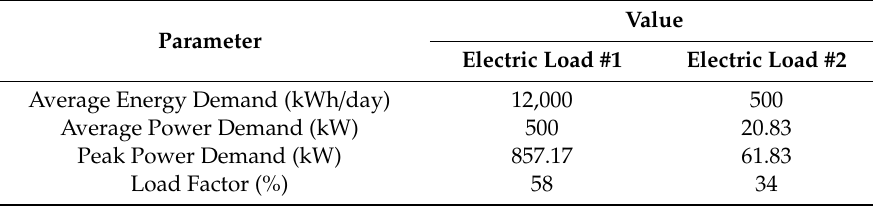
Figure 1. Total electrical load profile (first year of project lifetime). Table 1. Specifications of the primary electric load.